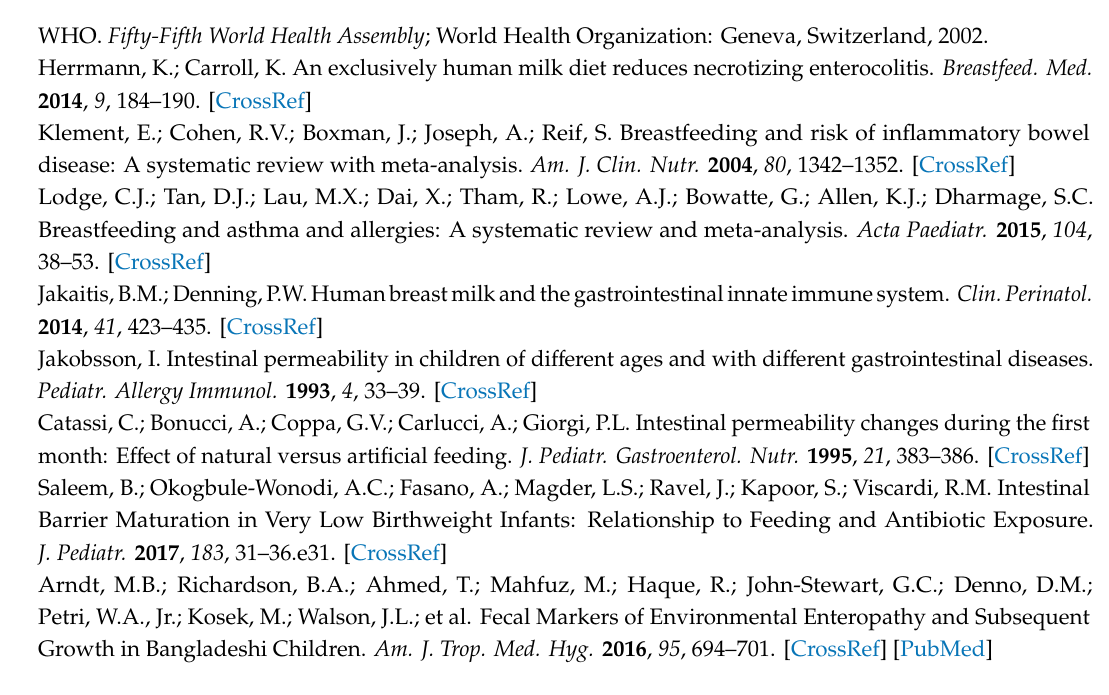
Table S1: HMO concentration [mg / mL] and composition of the 49 treatments, as well as TEER and FD4 mean results before and after